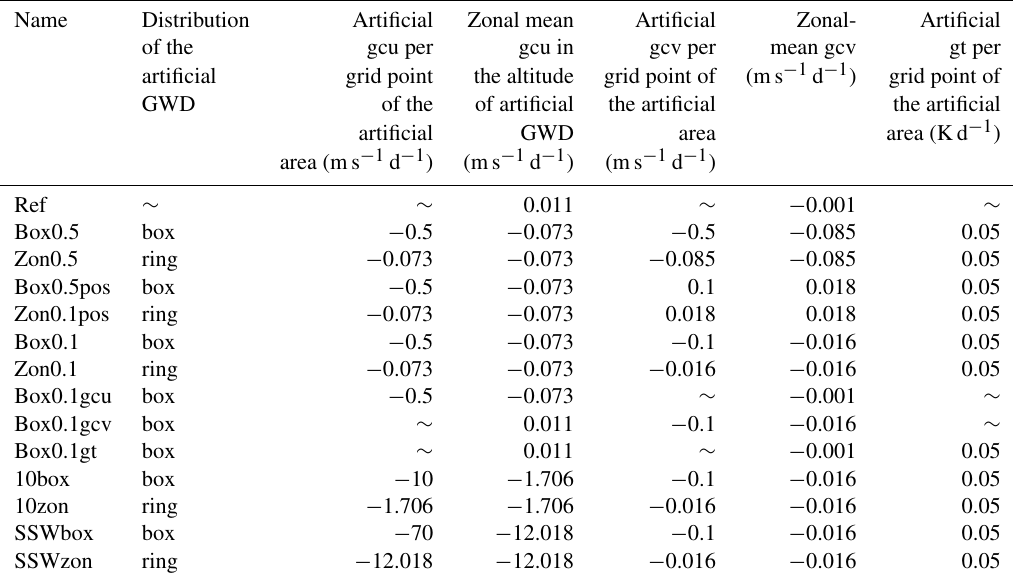
Table 1. Sensitivity simulation names and GWD settings for zonal wind drag (gcu), meridional wind drag (gcv) and heating due to GWs (gt) within the box. Note the gcu enhancements are negative because the drag is westward directed. The distribution describes whether the artificially enhanced GWD is implemented only for certain longitudes (box) or zonally uniform (zon). The tilde “ ∼ ” indicates that values are unchanged with regard to the reference